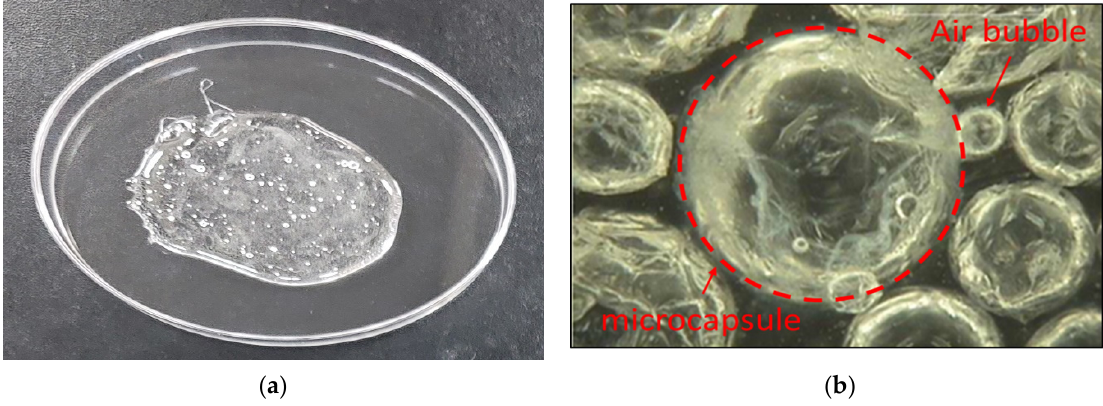
Figure 1. Microencapsulation of the core material as a healing material: ( a ) mixture of silicates; ( b ) encapsulated mixture of silicates.